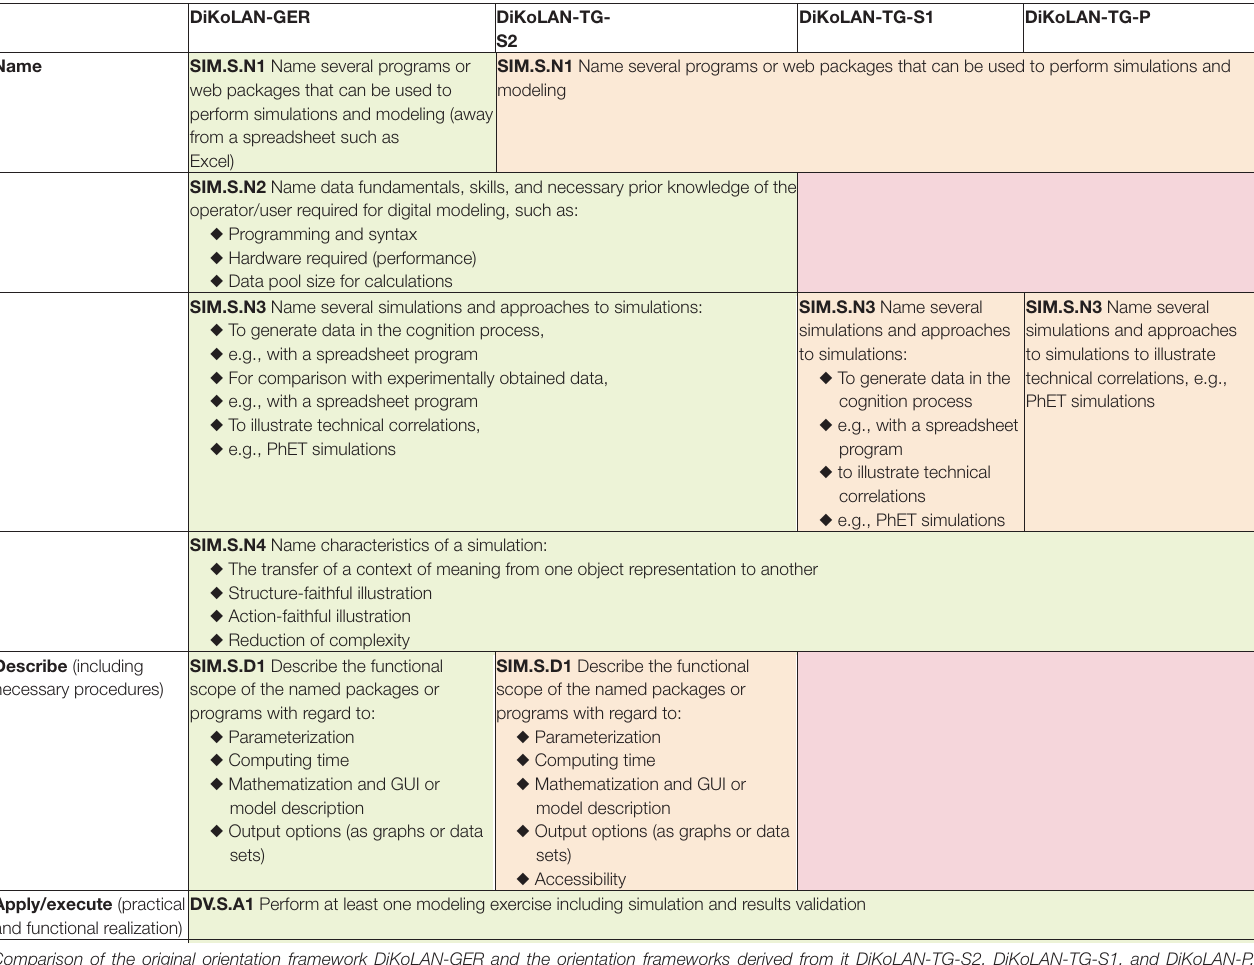
TABLE 3 | Exemplary excerpt from the full results in the Supplementary Material